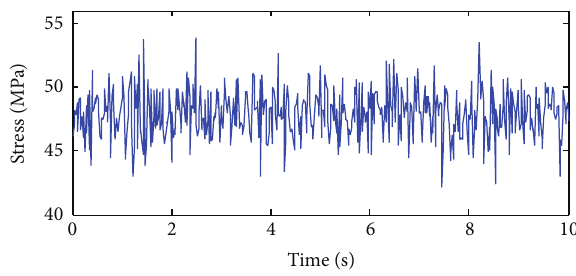
Figure 11: The time series of the strain sensor with noise.